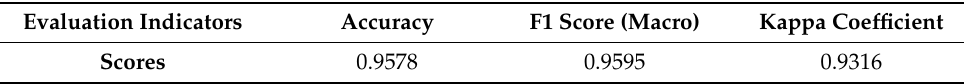
Figure 11. Multilayer perceptron confusion matrix. Table 2. Multilayer perceptron model evaluation indicator